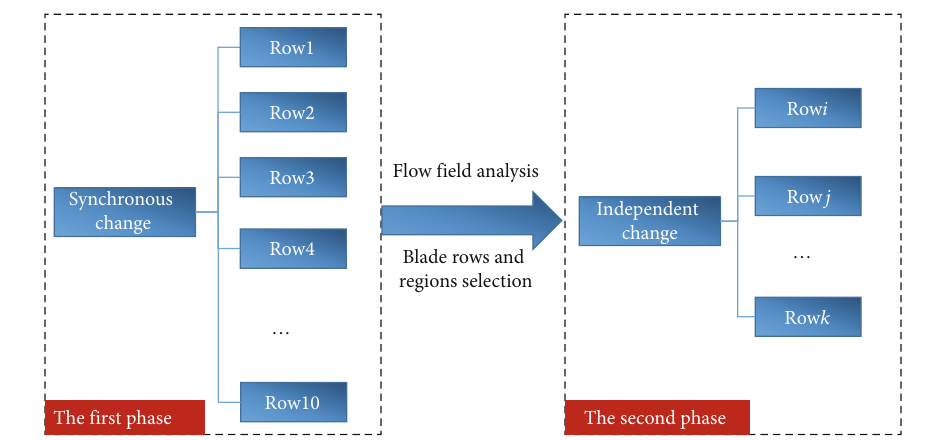
Figure 6: Optimization strategy diagram.